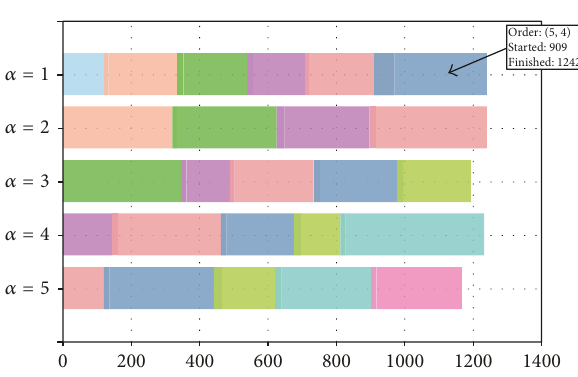
Figure 2: Results of the simulation process for 𝐴 = 5